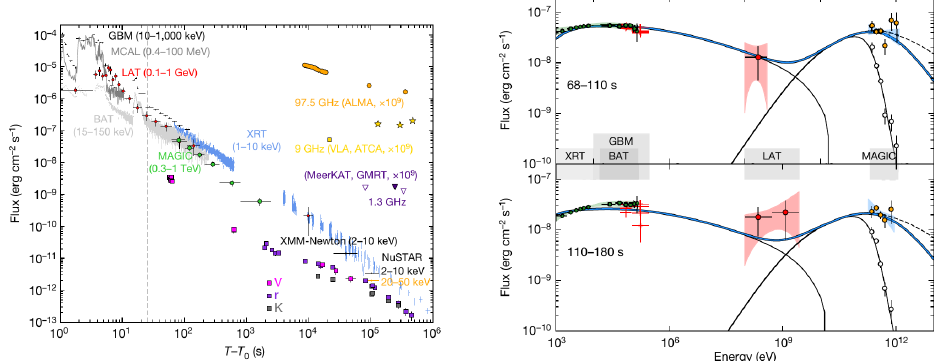
Figure 6. Left : Multi-wavelength (Radio to TeV γ -rays) lightcurve of GRB 190114C. The dashed verticle line indicates the time when the highly variable prompt emission ended. Right : Broadband high-energy spectrum of GRB 190114C at different time intervals along with the synchrotron + SSC model fits. The shaded contours shown in different colors indicate the 1 σ uncertainties on the model fit to the data. MAGIC data points shown in yellow have been corrected for the EBL absorption, whereas the open white circles are the actual observations. The black dashed curve shows the SSC spectral component without attenuation from internal γγ and EBL absorption. Figures from [173] (Reprinted by permission from Springer Nature Customer Service Center GmbH: Springer Nature, Observation of inverse Compton emission from a long γ -ray burst, MAGIC Collaboration,